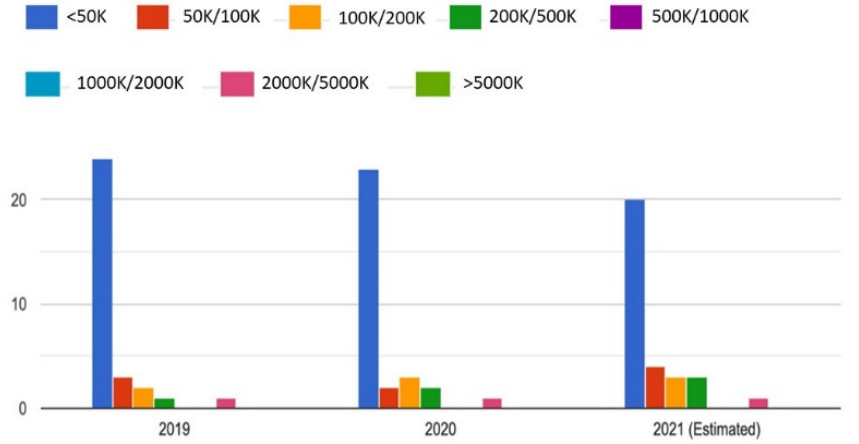
Figure 4. Online sales. Data source: Survey conducted by author.